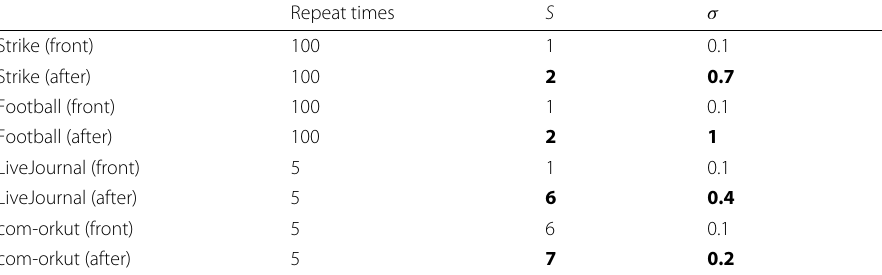
Table 5 Parameter comparison before and after in parameter experiments